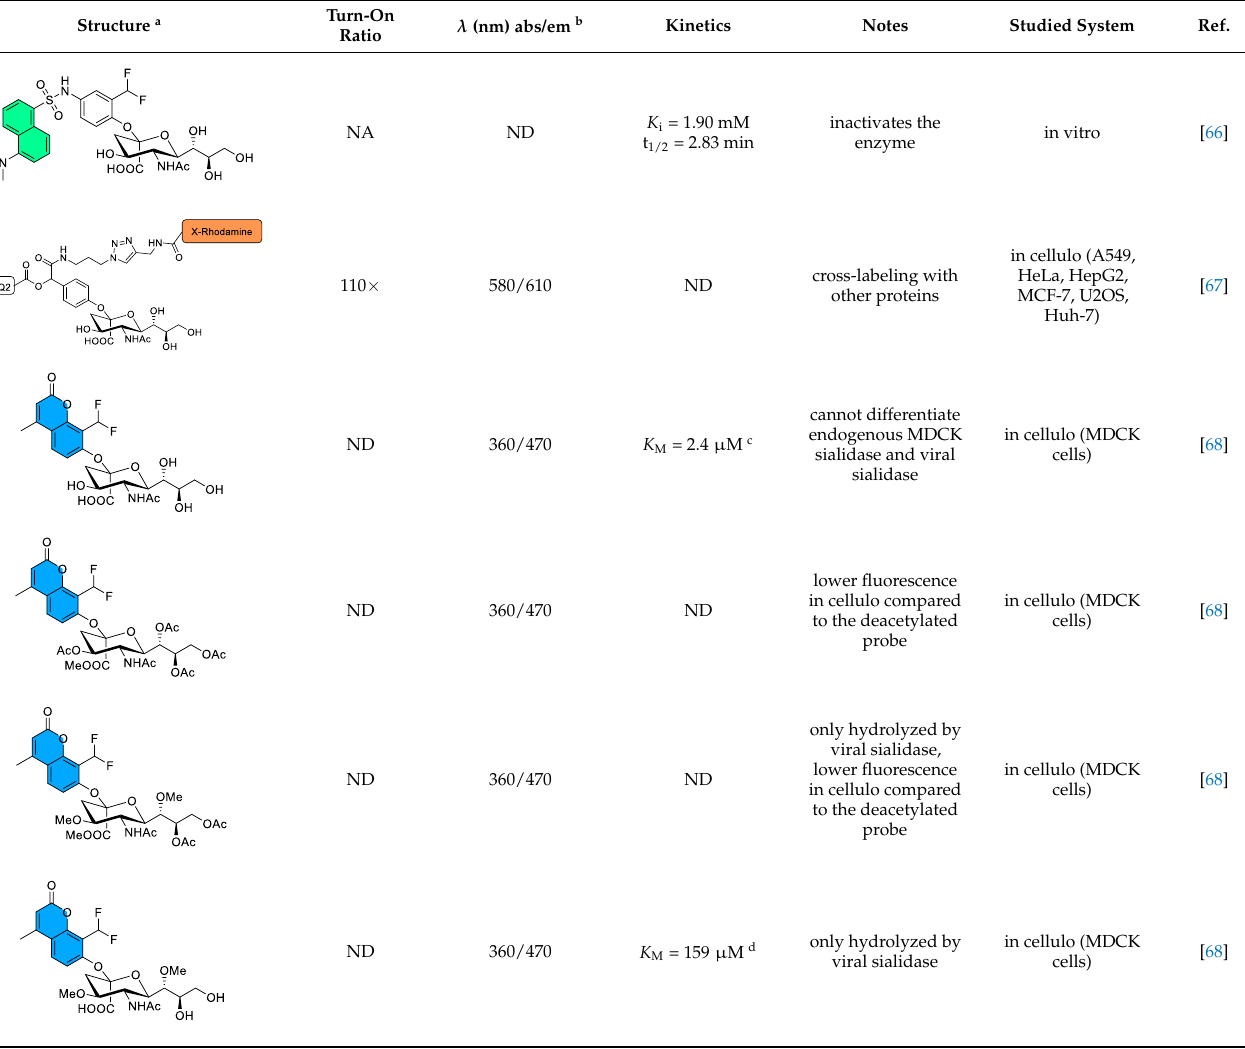
Table 6. Activity-based probes for neuraminidases.